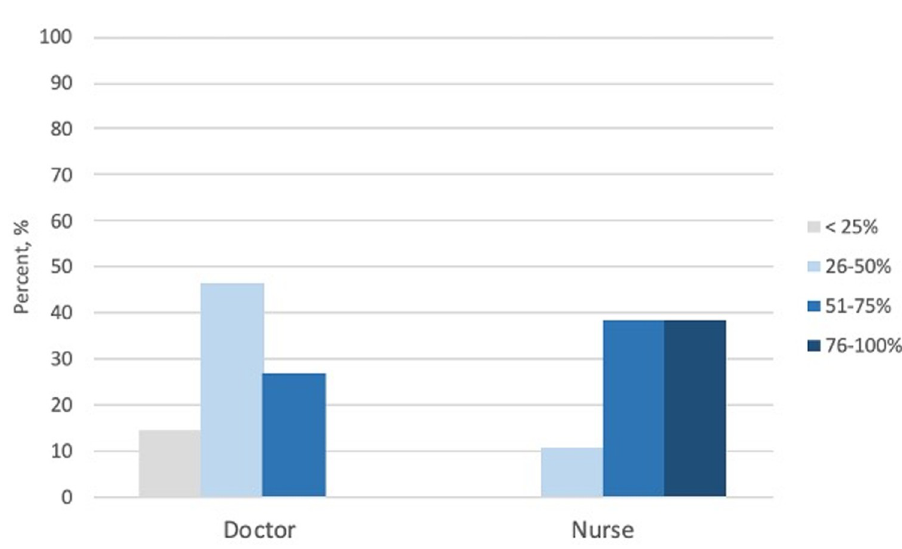
Fig 2. In your home country, what percentage of doctors or nurses are women? volunteer estimates